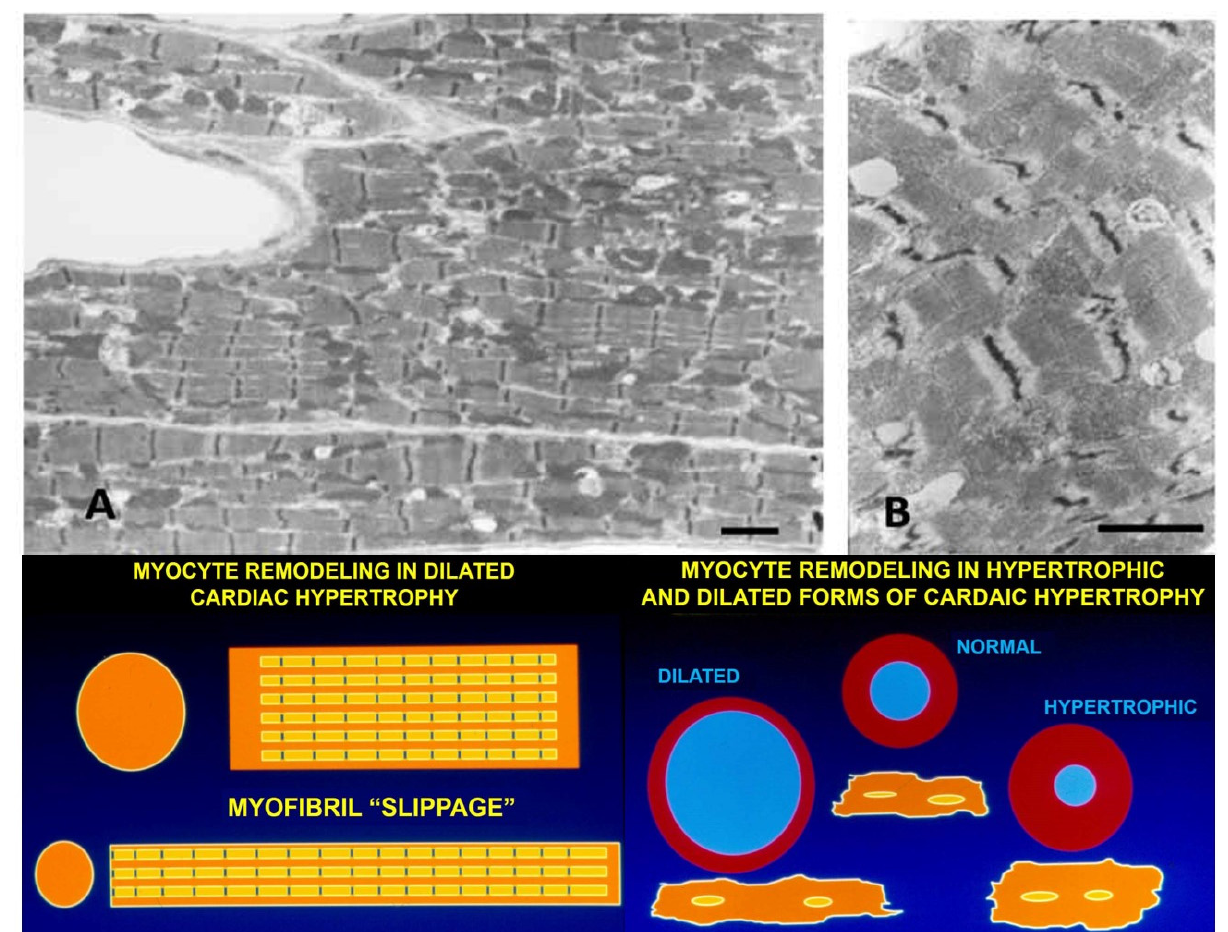
Figure 6. ( A , B ) Electron micrographs of myocardium from a dog with pacing-induced eccentric hypertrophy and increased end-diastolic pressure. Due to induced stretch, sarcomeres have lost their normal alignment within myofibrils. Compare with Figure 5. Bar = 2 µm in each. Lower panels: schematic illustrations of myofiber rearrangement and cell size change in dilated and hypertrophic cardiomyopathy.